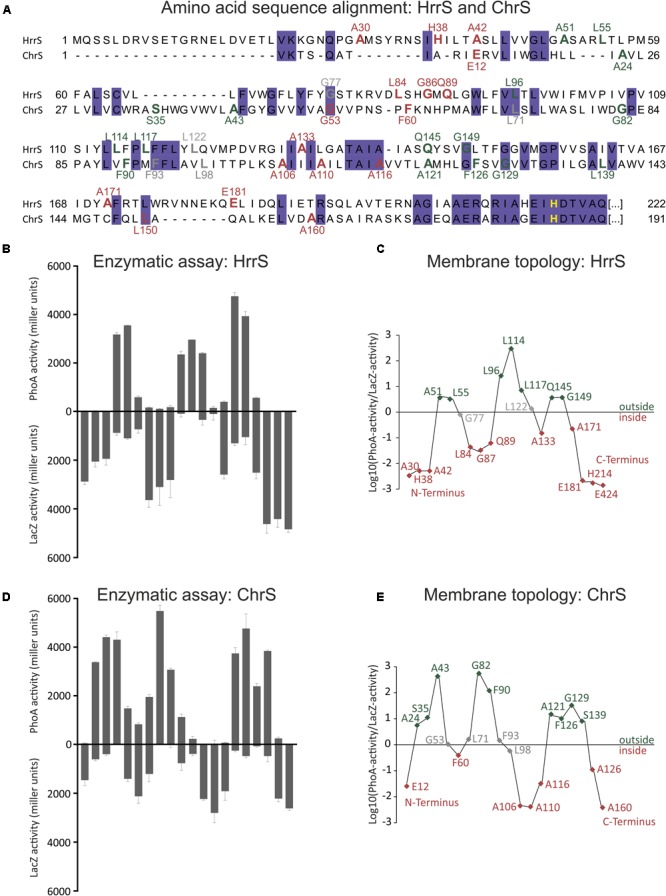
Experimental analysis of HrrS and ChrS membrane topology. (A) Sequence alignment of the N-terminal sensor domain of C. glutamicum HrrS and ChrS. A total of 20 truncated versions of HrrS or ChrS fused to the alkaline phosphatase (PhoA) or the β-galactosidase (LacZ) at the indicated amino acids positions were produced in E. coli TG-1 (A). Based on the results indicated in (B–E) fusion residues are marked in red (inside) or green (outside). (B)+(D): Enzymatic activities of 20 PhoA (up) and LacZ (down) fusions of HrrS and ChrS (given in miller units). The enzymatic activity of all fusion proteins was measured as described in the Section “Materials and Methods.” Data represent average values of three independent biological replicates. (C)+(E): Log10 of the PhoA-activity/LacZ-activity ratios. The graph outlines the membrane topology of the histidine kinases (HKs) HrrS and ChrS: a ratio of > ∼0.5 indicates an extracellular and < ∼-0.5 a cytoplasmic localization.